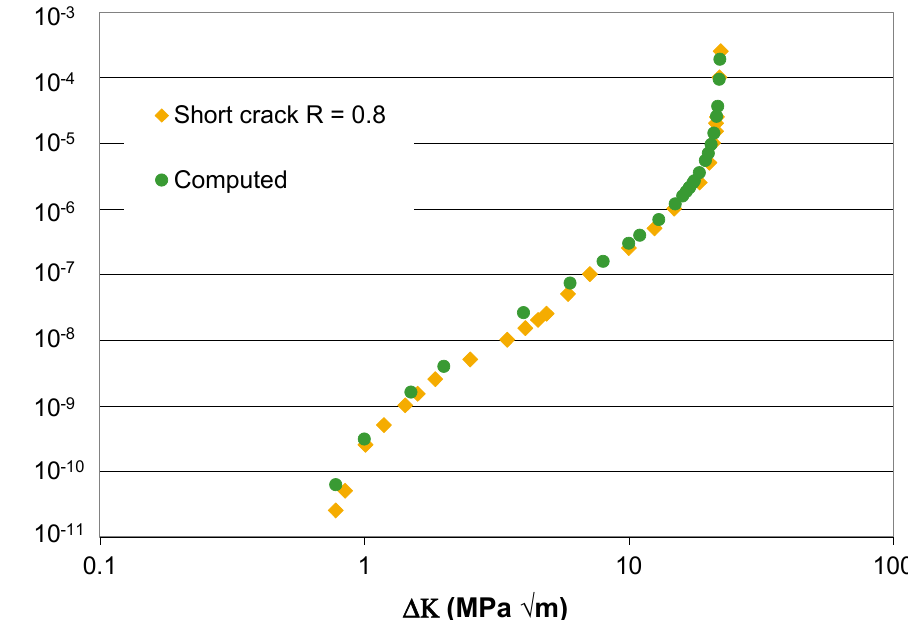
Figure 4. Comparison with the small/short crack growth curve given in [42].